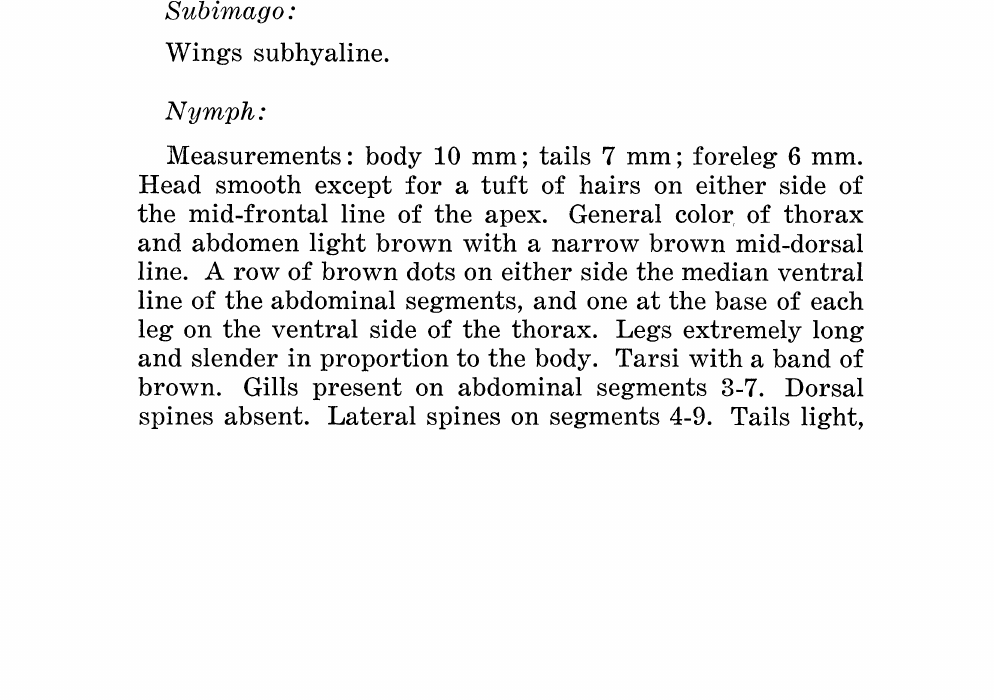
segments grayish, 8th yellowish-gray, 9th and 10th yellow.